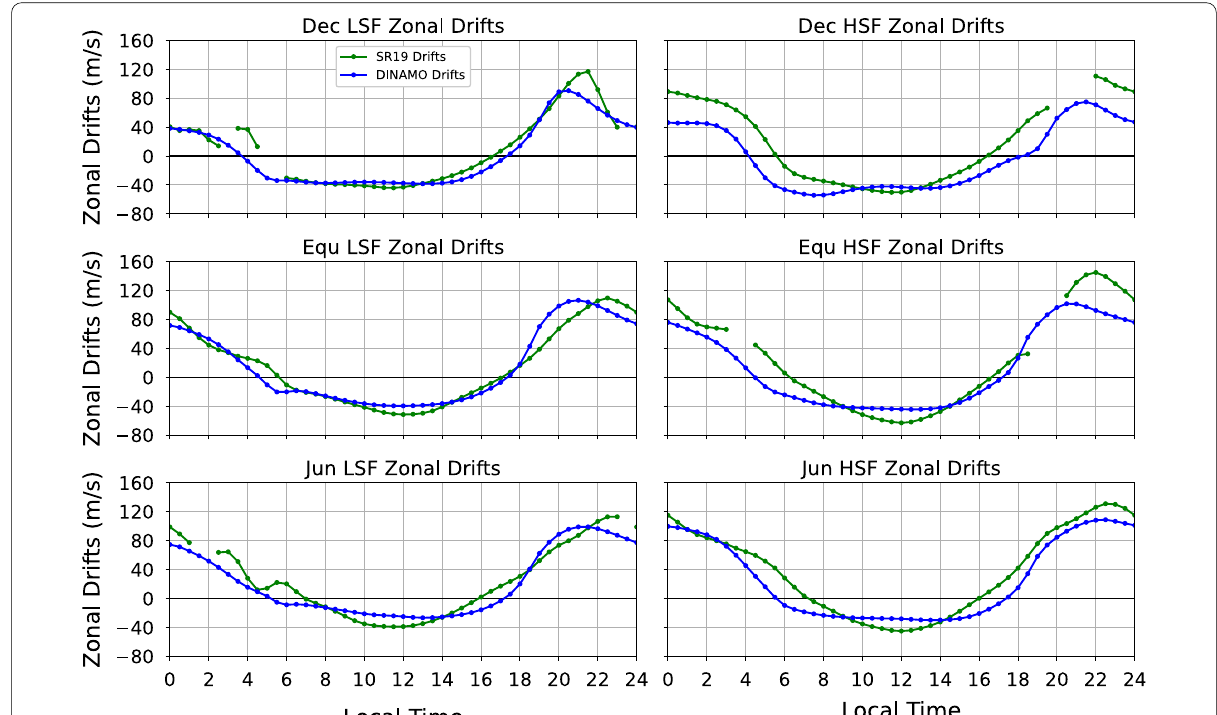
Fig. 2 Behavior of the zonal plasma drifts as a function of local time for different seasons (rows) and solar flux conditions (columns). The blue curves represent results from the DINAMO model at 360 km. The green curves represent the Jicamarca ISR observations presented by Shidler et al. (2019) for altitudes of 360 40 ±